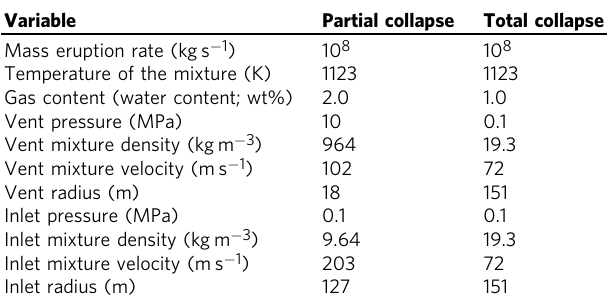
Table 1 Input parameters used for the end-members Variable Partial